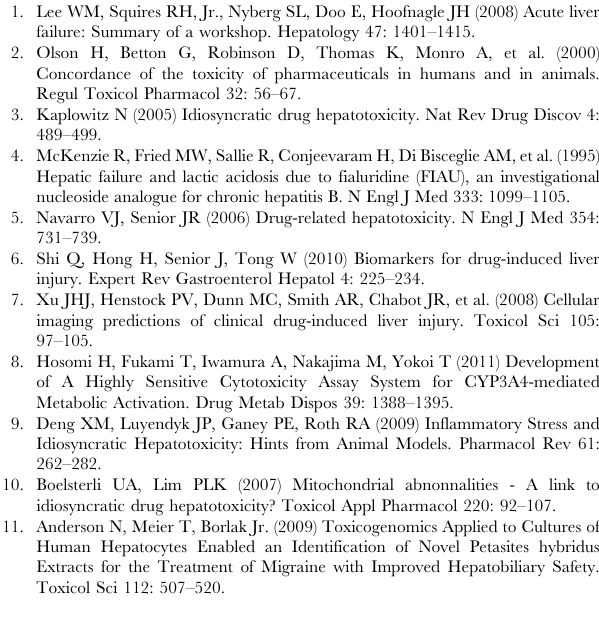
Figure S1 The distribution of 888 drugs over 473 side effects and vice versa. Table S1 Information for the 473 side effects. Informa- tion included: (1) the number of drugs involved; (2) system organ classes (SOC) number and annotation of MedDRA; and (3) the distribution of 473 side effects in the SOC levels of MedDRA. Table S2 Information of the validation set from three literature datasets (i.e., LTKB-BD, PfizerData, and O’Brien et al.) for drugs that do not overlap with SIDER. Table S3 The top toxicity functions of Module 1. Table S4 The literature proof about the co-occurrence between the HepSE terms and protein target. The EntrezGene ID and PubMed ID (which can be linked to PubMed directly) are provided. Table S5 The QSAR models performance for the 13 HepSEs and an additional two terms from the Investi- gation category, and for 14 HepSEs as suggested by an expert. Table S6 Information for datasets. Datasets include: (1) SIDER, (2) LTKB-BD, (3) PfizerData, (4) O’Brien et al., and (5) Small molecules in